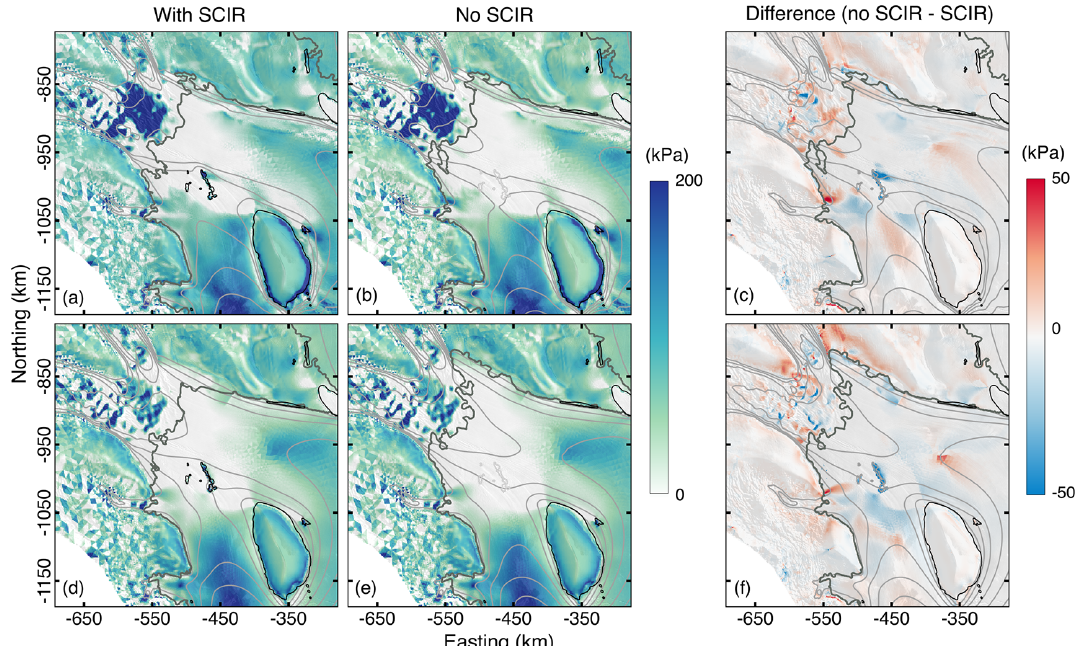
Figure 7. The longitudinal tensile stress + R ll acting on the RIS and tributary ice streams with and without the SCIR. In panels (a) – (c) , the simulation is initialised with B inv . In panels (d) – (f) , the simulation is initialised with B u . In panels (a) and (b) , the unusually high + R ll values at the outlet of MacIS and BIS are due to relatively high B inv values inferred during model initialisation.